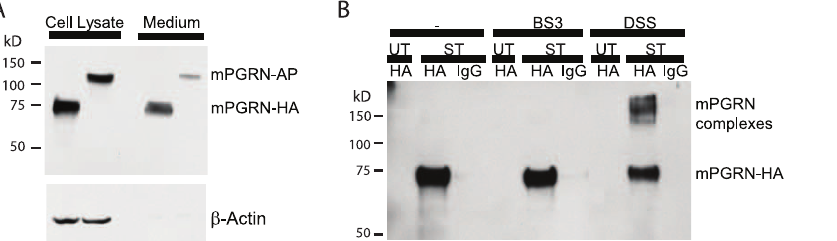
Figure 1. Biochemical identification of PGRN-interacting proteins. ( A ) mPGRN-AP or mPGRN-HA fusion protein constructs were stably transfected into HEK293 cells. Cell lysates or culture medium was analyzed on Western blot with anti-mPGRN antibody. This antibody specifically recognizes mPGRN but not the endogenous hPGRN in HEK293 cells. b -actin was used as the loading control. ( B ) Stably transfected HEK293 cells expressing mPGRN-HA were treated with cross linkers, followed by immunoprecipitation (IP) with HA antibody or control IgG. Immunoisolates were